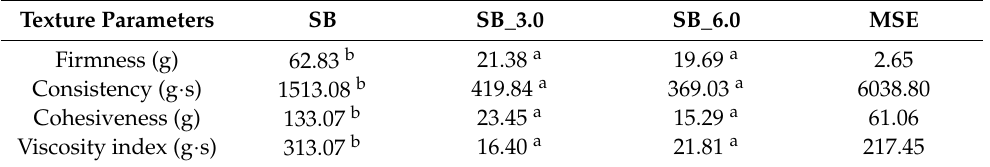
Table 4. Texture profile of fermented soy beverage with acai